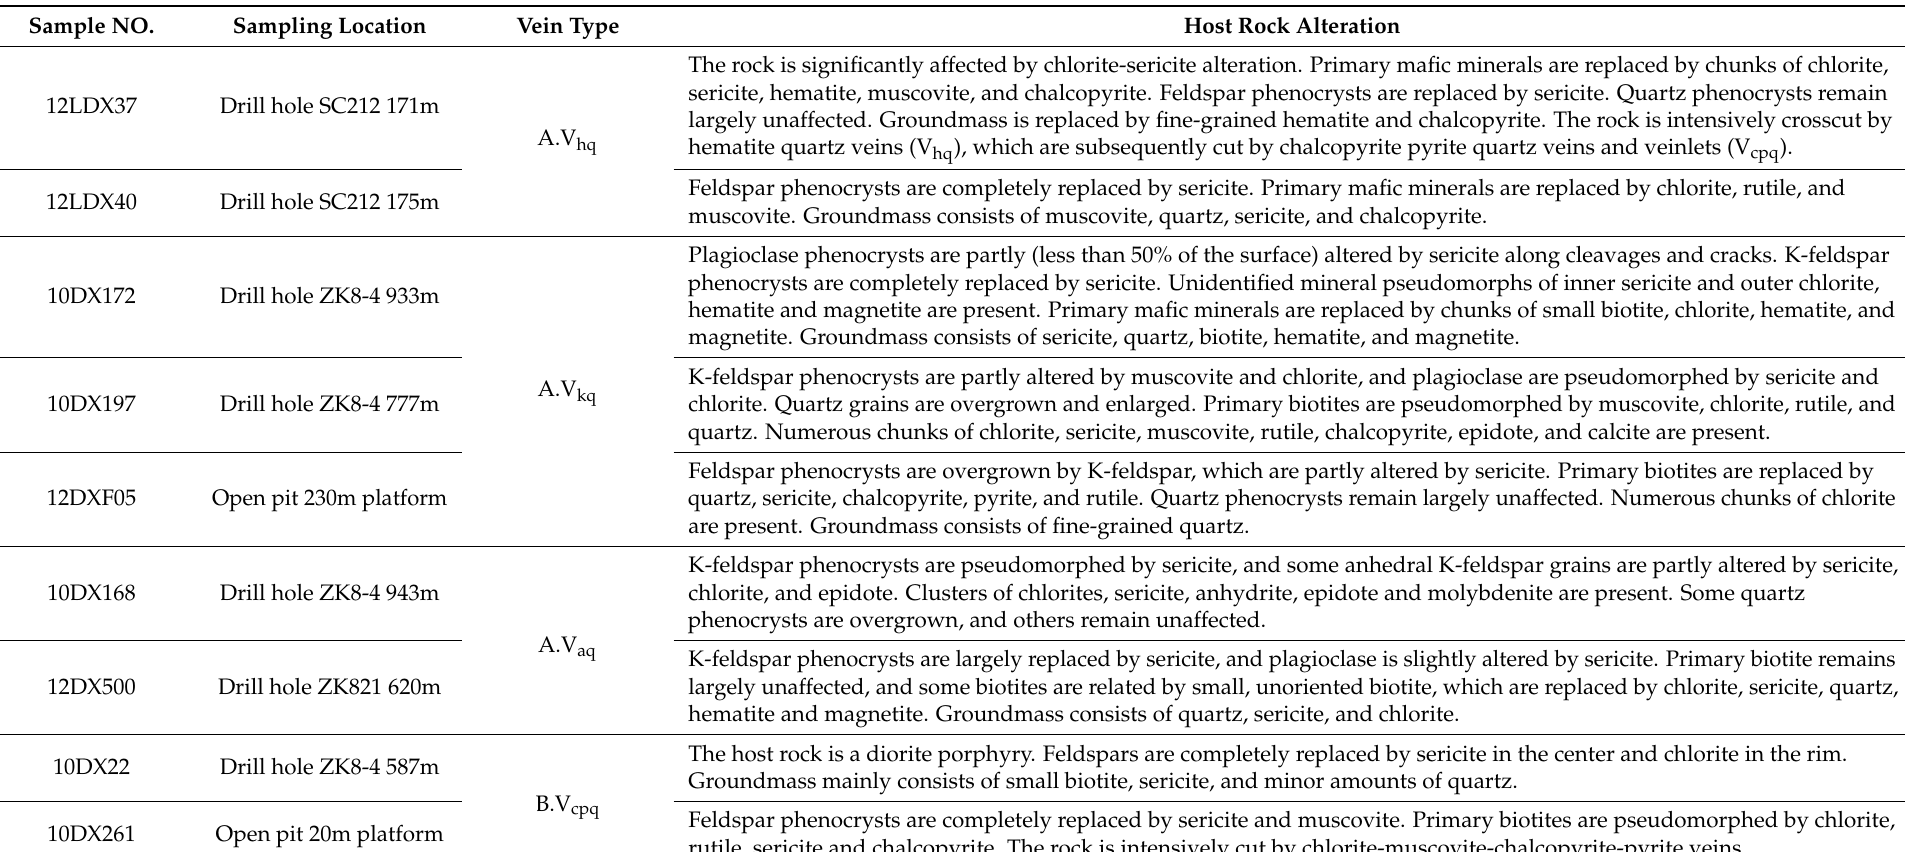
Table 1. A summary of sampling locality and petrography of the analyzed rock samples of the Tongchang porphyry Cu deposit. Sample